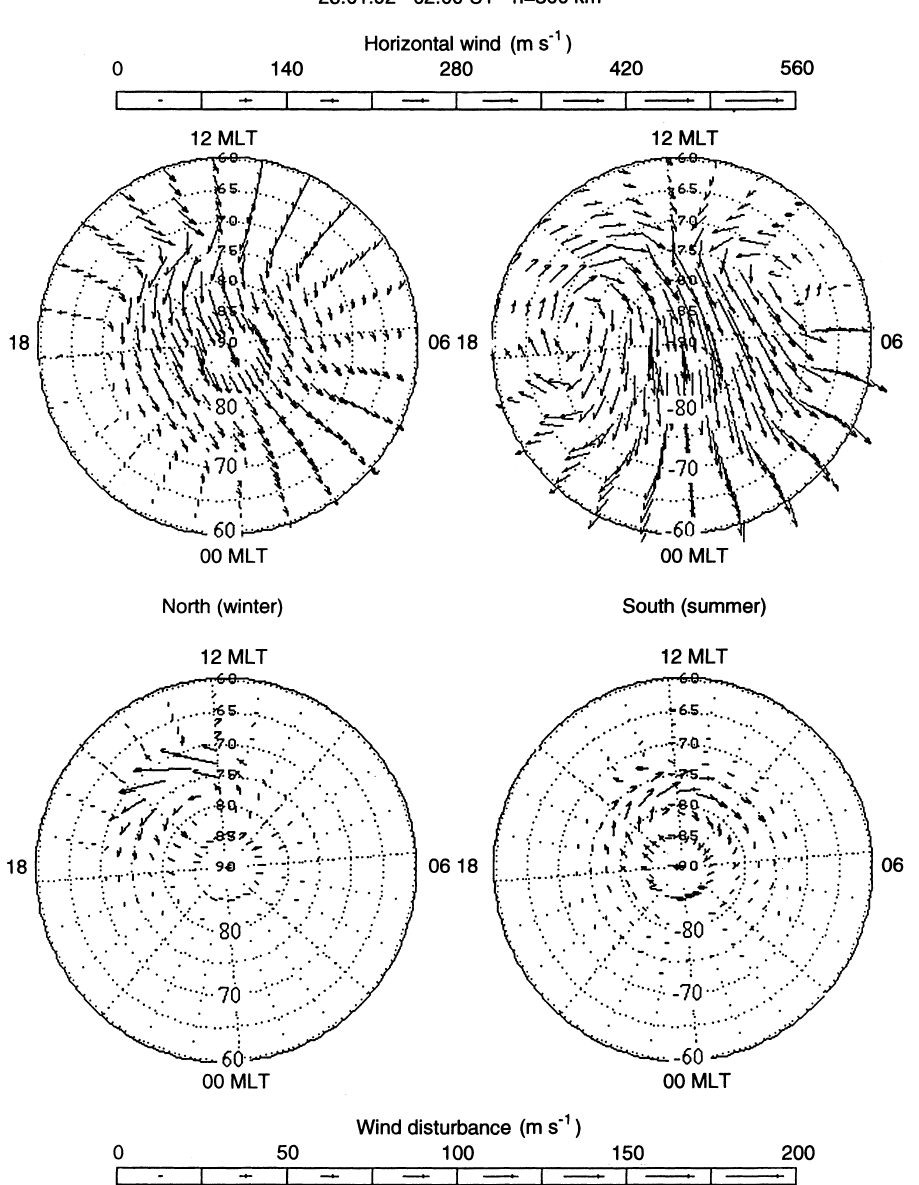
Fig. 8. The calculated patterns of the horizontal thermospheric wind velocity ( top panel ) and wind disturbance ( bottom panel ) at height 300 km at 0200 UT for 28 January, 1992 in the Northern (winter, left plots ) and Southern (summer, right plots ) Hemispheres (variant 2 of